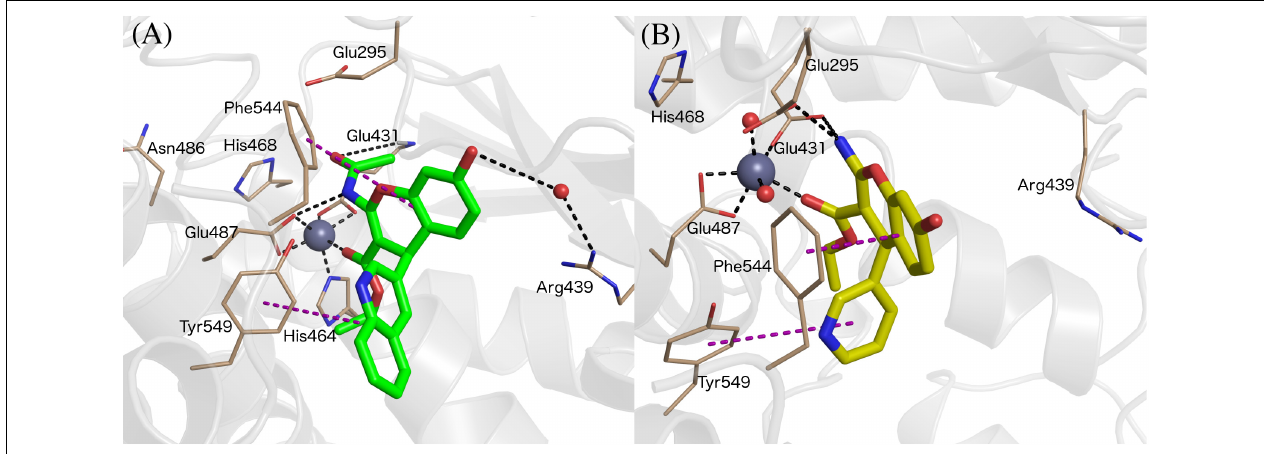
FIGURE 3 | Binding mode of compound 9 (panel A , green sticks), and 6 (panel B , yellow sticks) in IRAP as determined from the MD simulations used for LIE calculations. Zn 2 + and water molecules are shown as gray and red spheres, respectively. All of the figures shown are extracted from representative snapshots of 2 ns MD simulations. H-bonds are shown as black dotted line, and π – stacking interactions in the purple color dashed line.